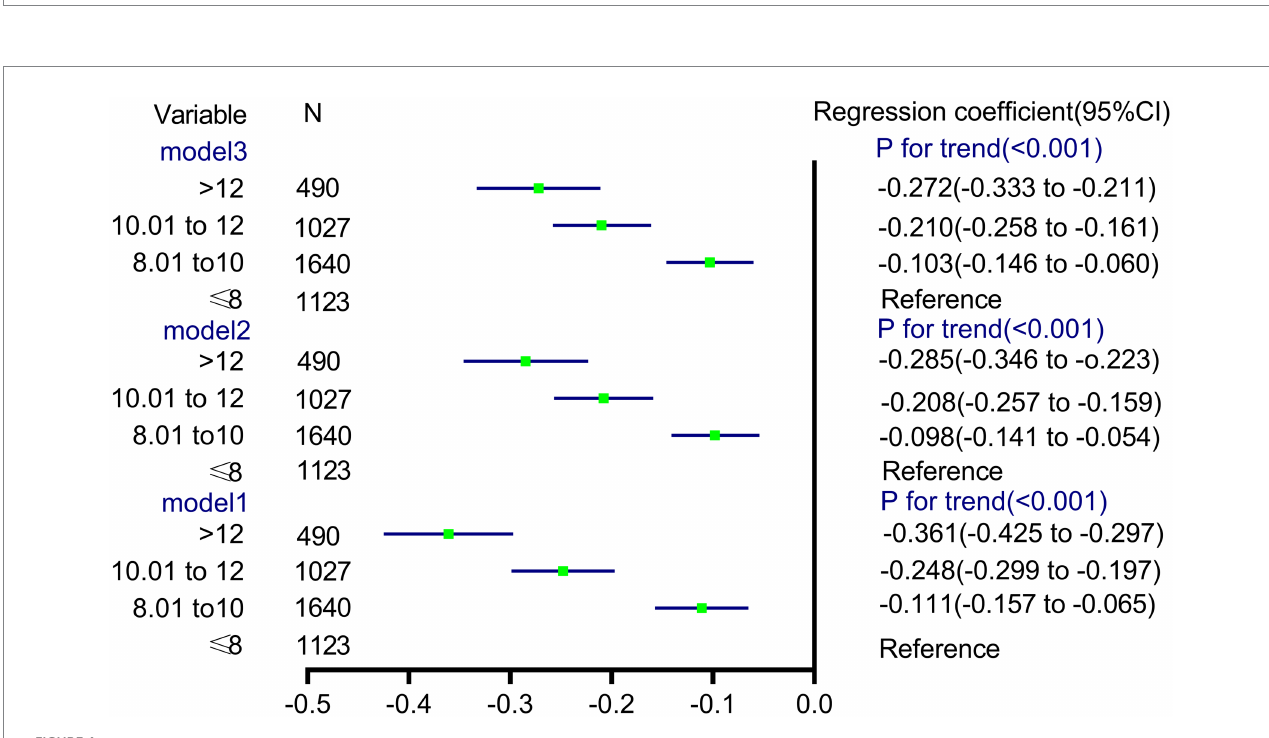
FIGURE 4 Differences in √ fetal fraction according to white blood cell count